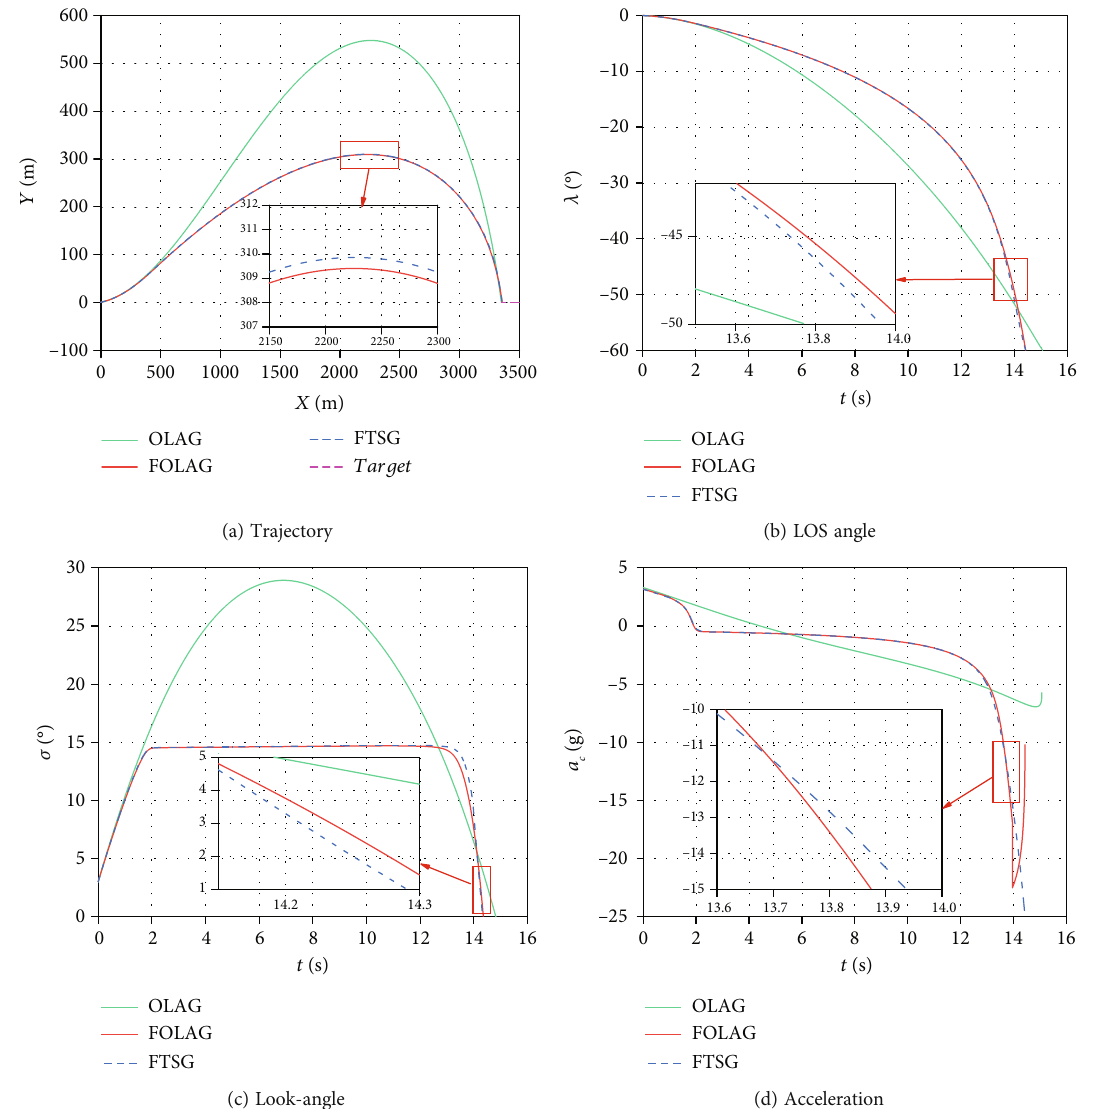
Figure 10: The comparison results of di ff erent guidance